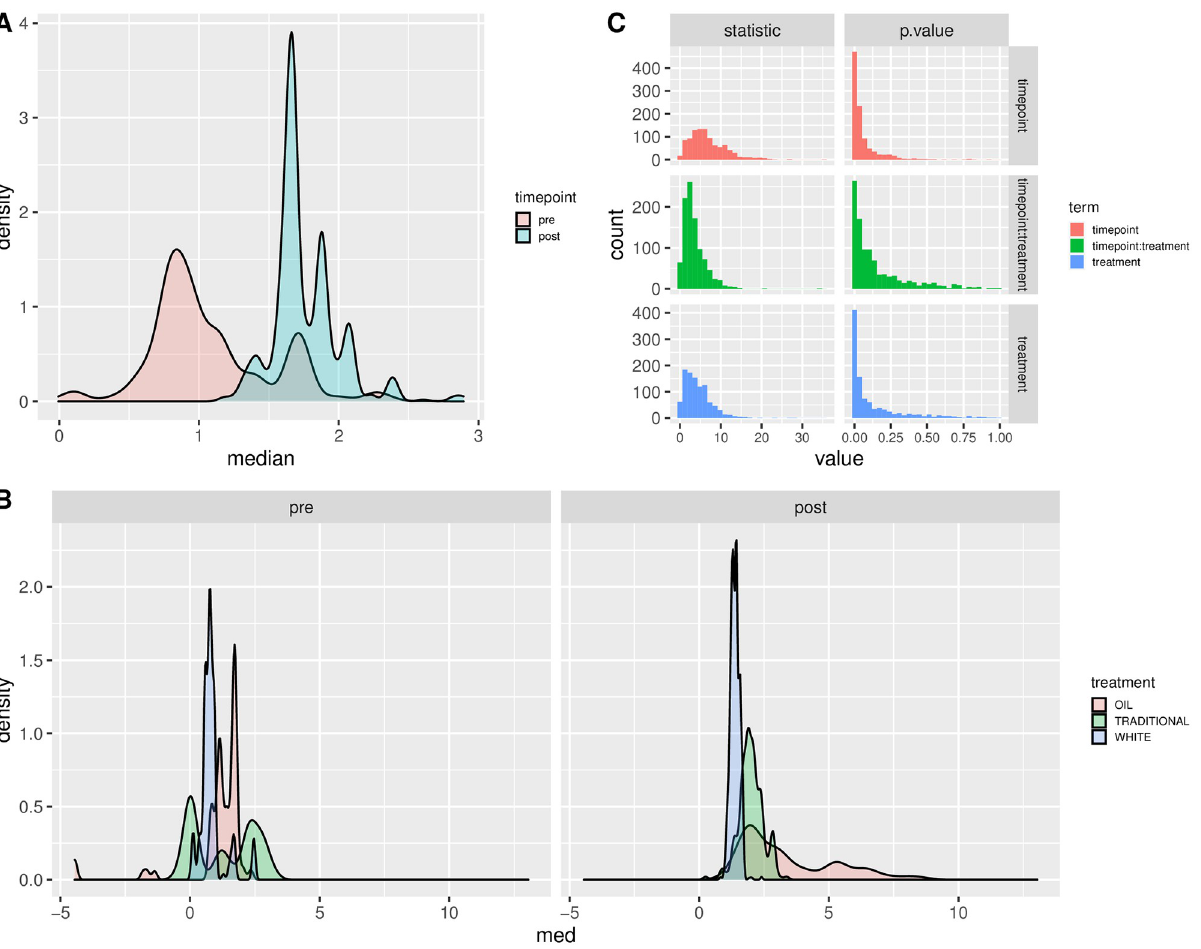
Fig 4. F:B ratio. F:B ratio before and after weaning (A) and between treatments at each time point (B). Results from 1000 bootstrapped replicates of the dataset. Results from bootstrapping regression (test statistic, p-values) are in pane C.